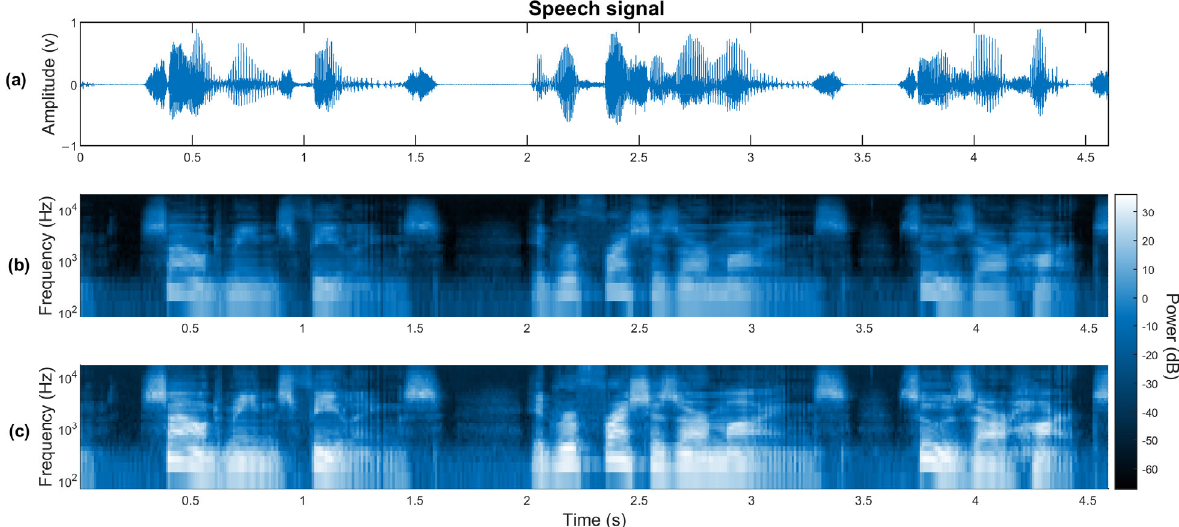
Figure 3. Illustrations of frequency features on a fragment of a speech signal. ( a ) Time signal. ( b ) Spectrogram based on MFCC. ( c ) Spectrogram based on BFCC.